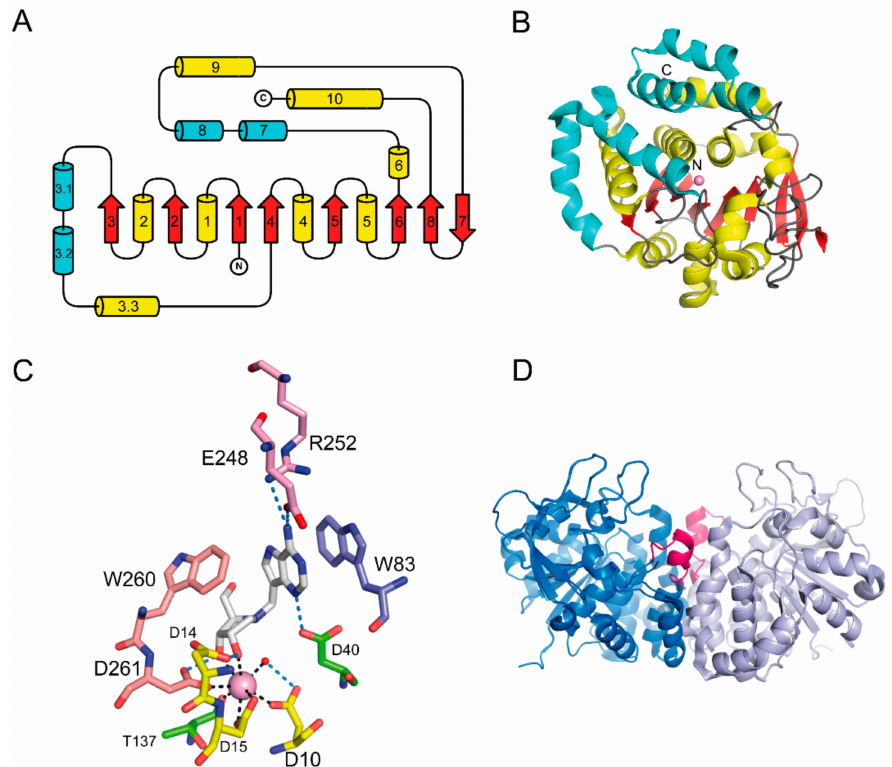
Figure 4. Group II NH structure. ( A ) Topology diagram of group II NHs. Four helical segments ( α 3.1, α 3.1, α 7, and α 8) are part of the monomer-monomer interface. ( B ) Ribbon diagram of the monomer of the T. brucei brucei IAG-NH (PDB code 4I71). ( C ) Active site of group II NHs. The T. brucei brucei IAG-NH in complex with the UAMC-0063 inhibitor shows the aromatic stacking between the aglycone and two signature Trp residues, along with specific hydrogen bonding to the base substituents. ( D ) Flexible loop conformational selection. The flexible loop in unliganded IAG-NH spanning residues 245–255 becomes ordered (pink) on binding of substrates or competitive